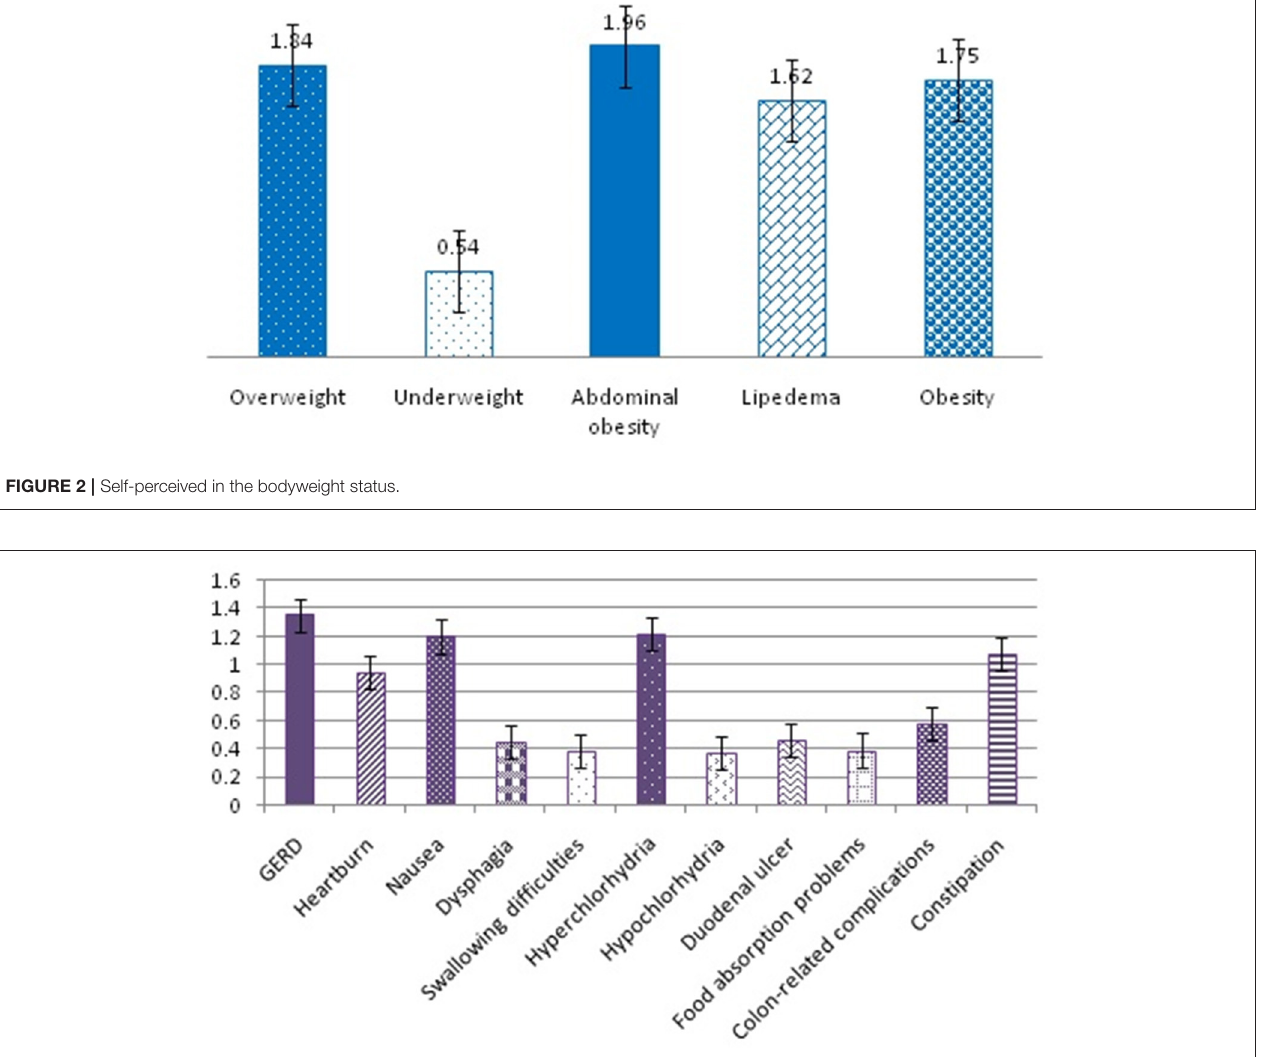
FIGURE 3 | Self-perceived in the gastrointestinal (GI)